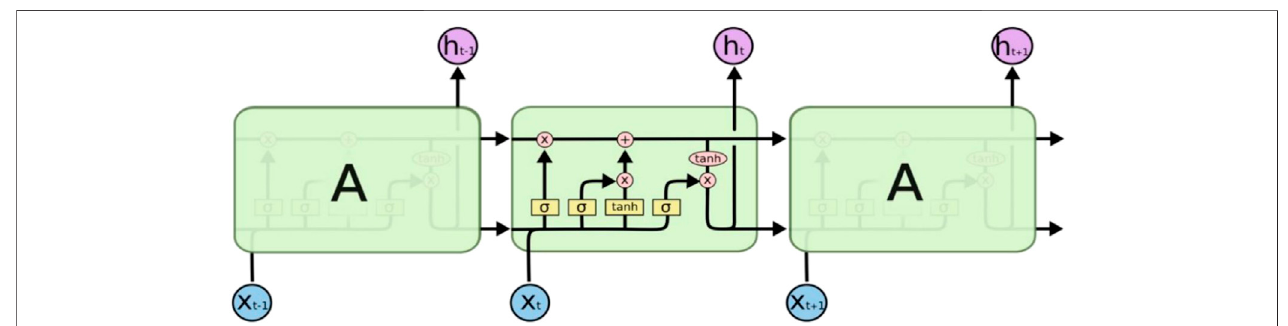
FIGURE 2 | The structure of the long short-term memory (LSTM) method unit [18].